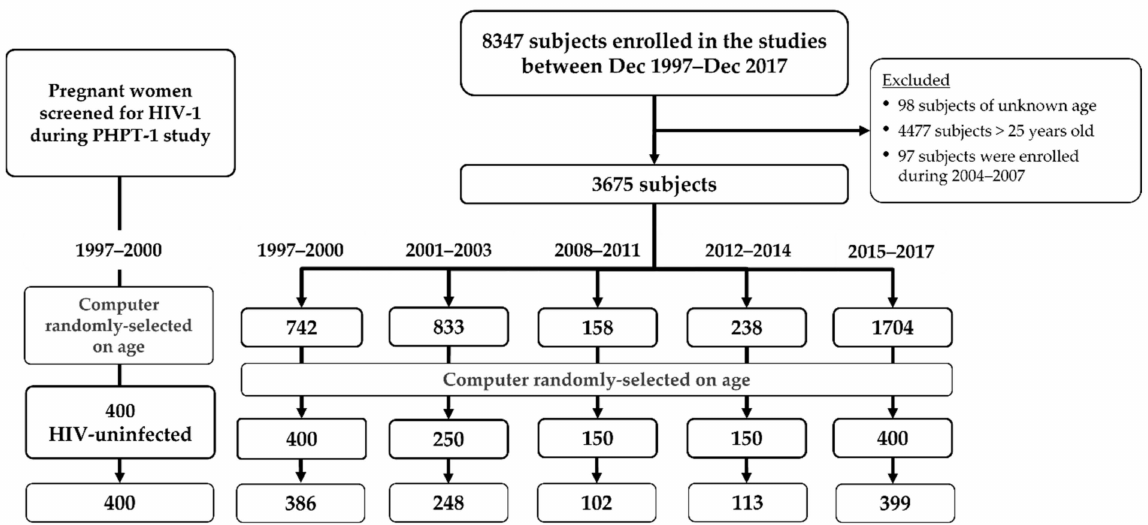
Figure 1. Study population: subjects were enrolled between 1997 and 2017, over five time periods: 1997–2000, 2001–2003, 2008–2011, 2012–2014 and 2015–2017. The target numbers of subjects randomly selected for each period were 400, 250, 150, 150 and 400, respectively. An additional group of 400 HIV-uninfected pregnant women enrolled in the 1997 − 1999 period was included. The bottom row indicates the number of selected subjects with the available